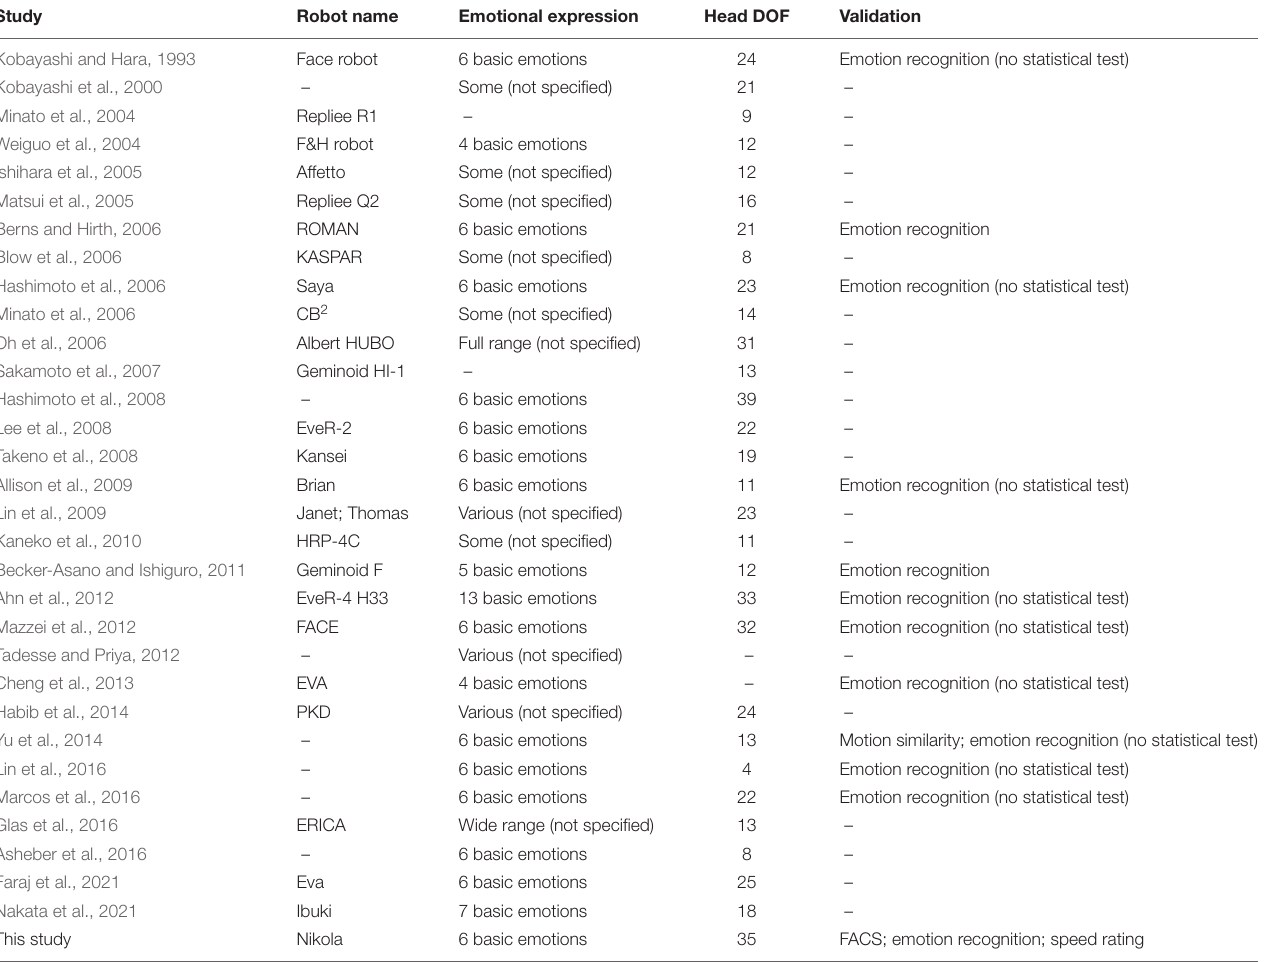
TABLE 1 | Summary of studies on androids’ emotional facial